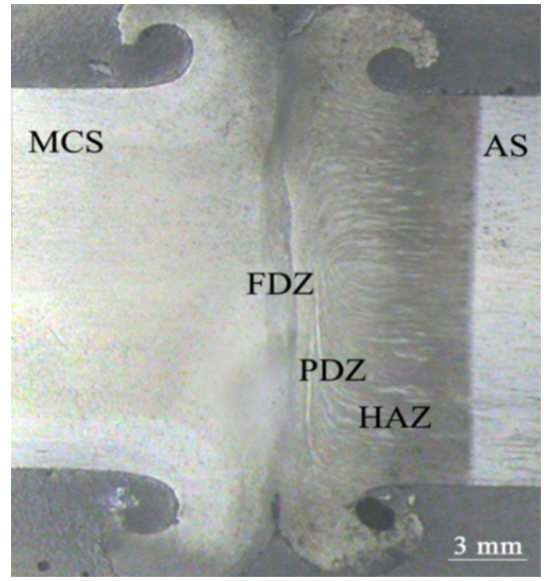
Figure 5: Macrostructure of the dissimilar